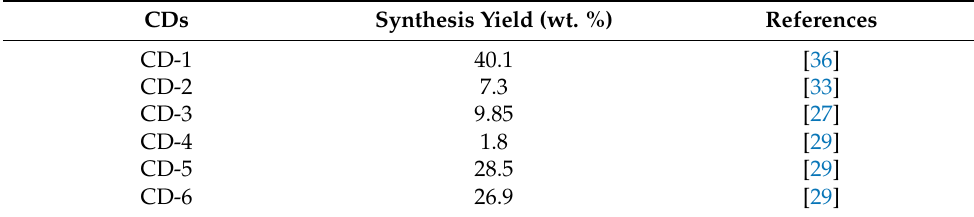
Table 1. Synthesis yield of each CD under study. CDs Synthesis Yield (wt.